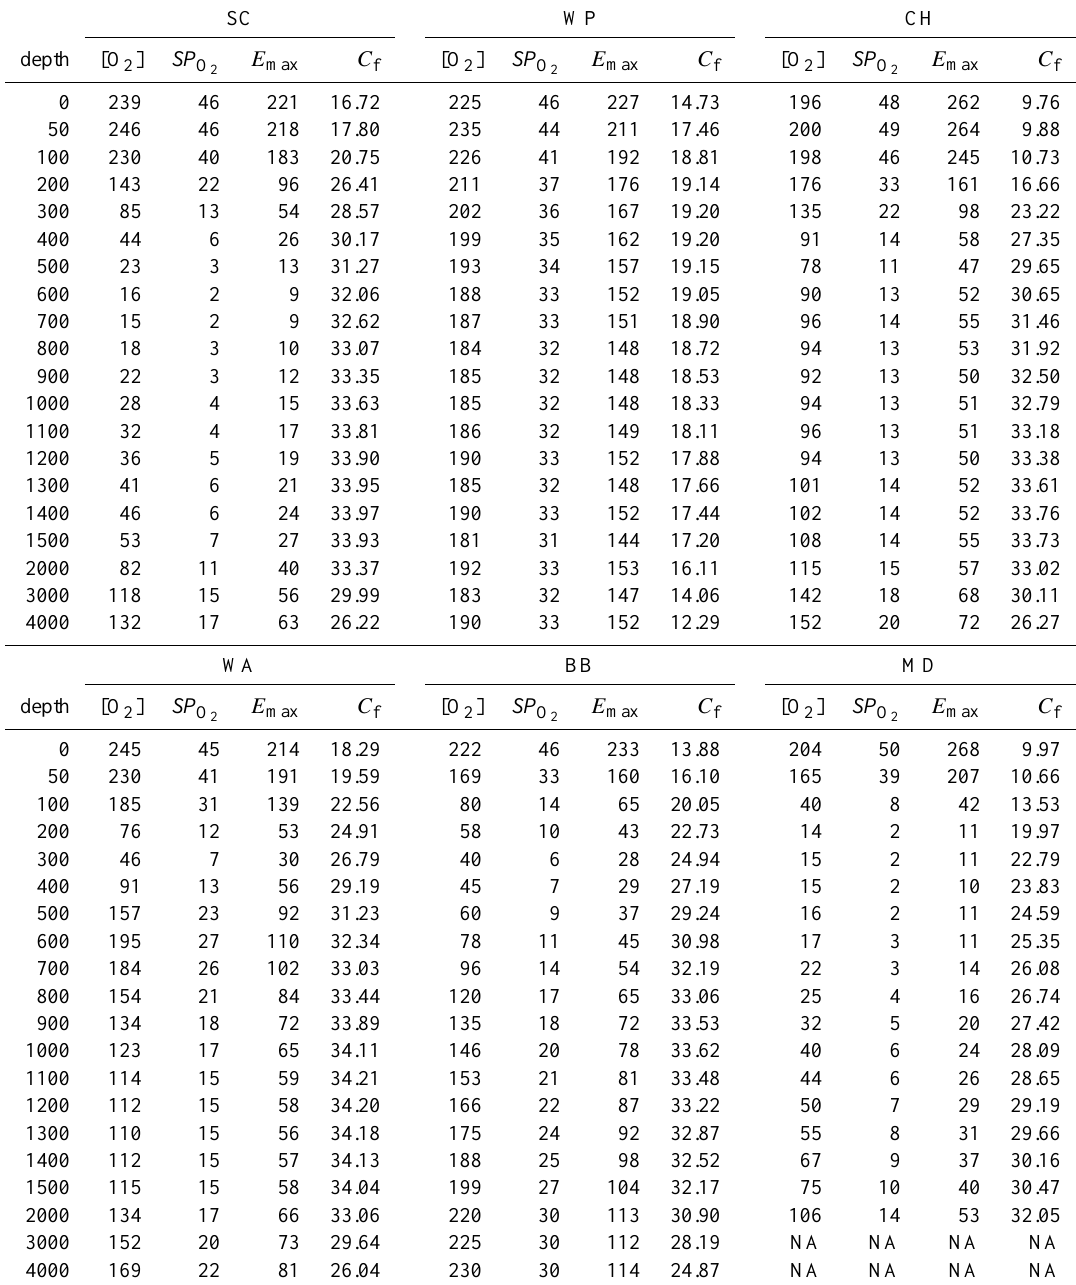
Table 3. Depth profiles of [O 2 ], SP O , E max , and C f for example stations around the world. Details on the tabulated quantities can 2